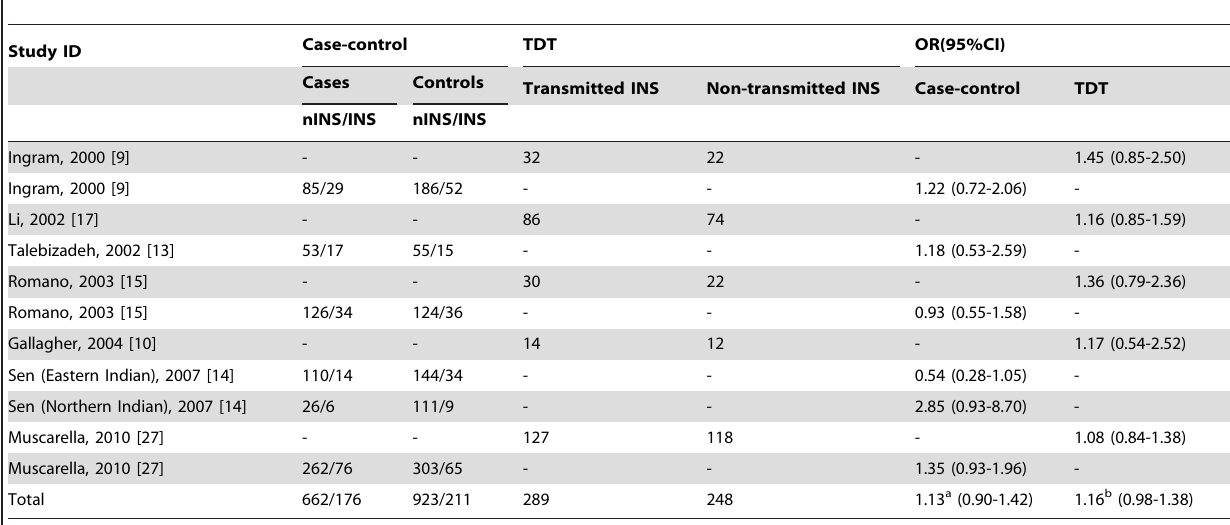
Table 3. Meta-analysis of case-control and TDT studies between the insertion variant in HOXB1 and ASD.